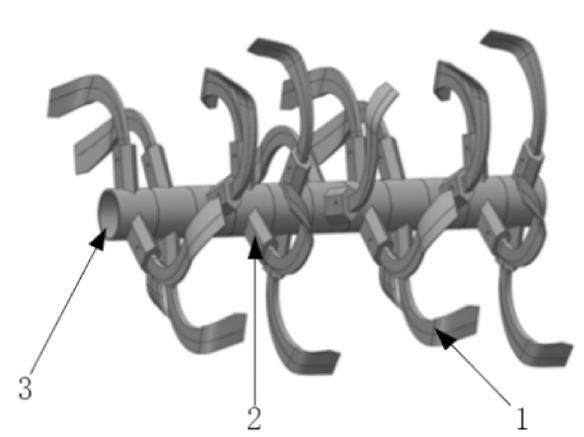
Figure 1. The models of the hose